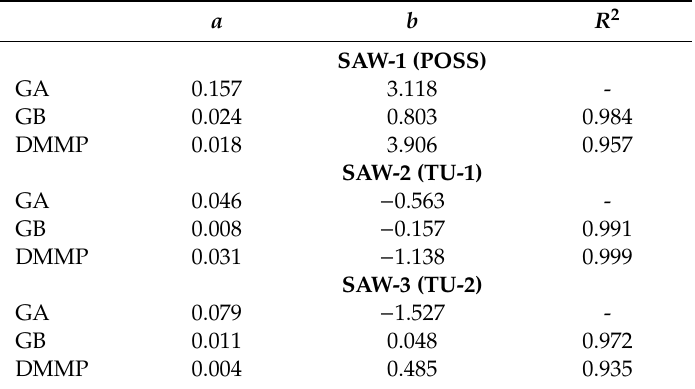
Figure 9. Response of the SAW sensors with different sensing materials of ( a ) POSS; ( b ) TU-1; and ( c ) TU-2 depending on the vapor type. Table 1. Linear parameters of the function ∆ f = ax + b : a , b , and R 2 are slope, intercept, and coefficient of determination, respectively.